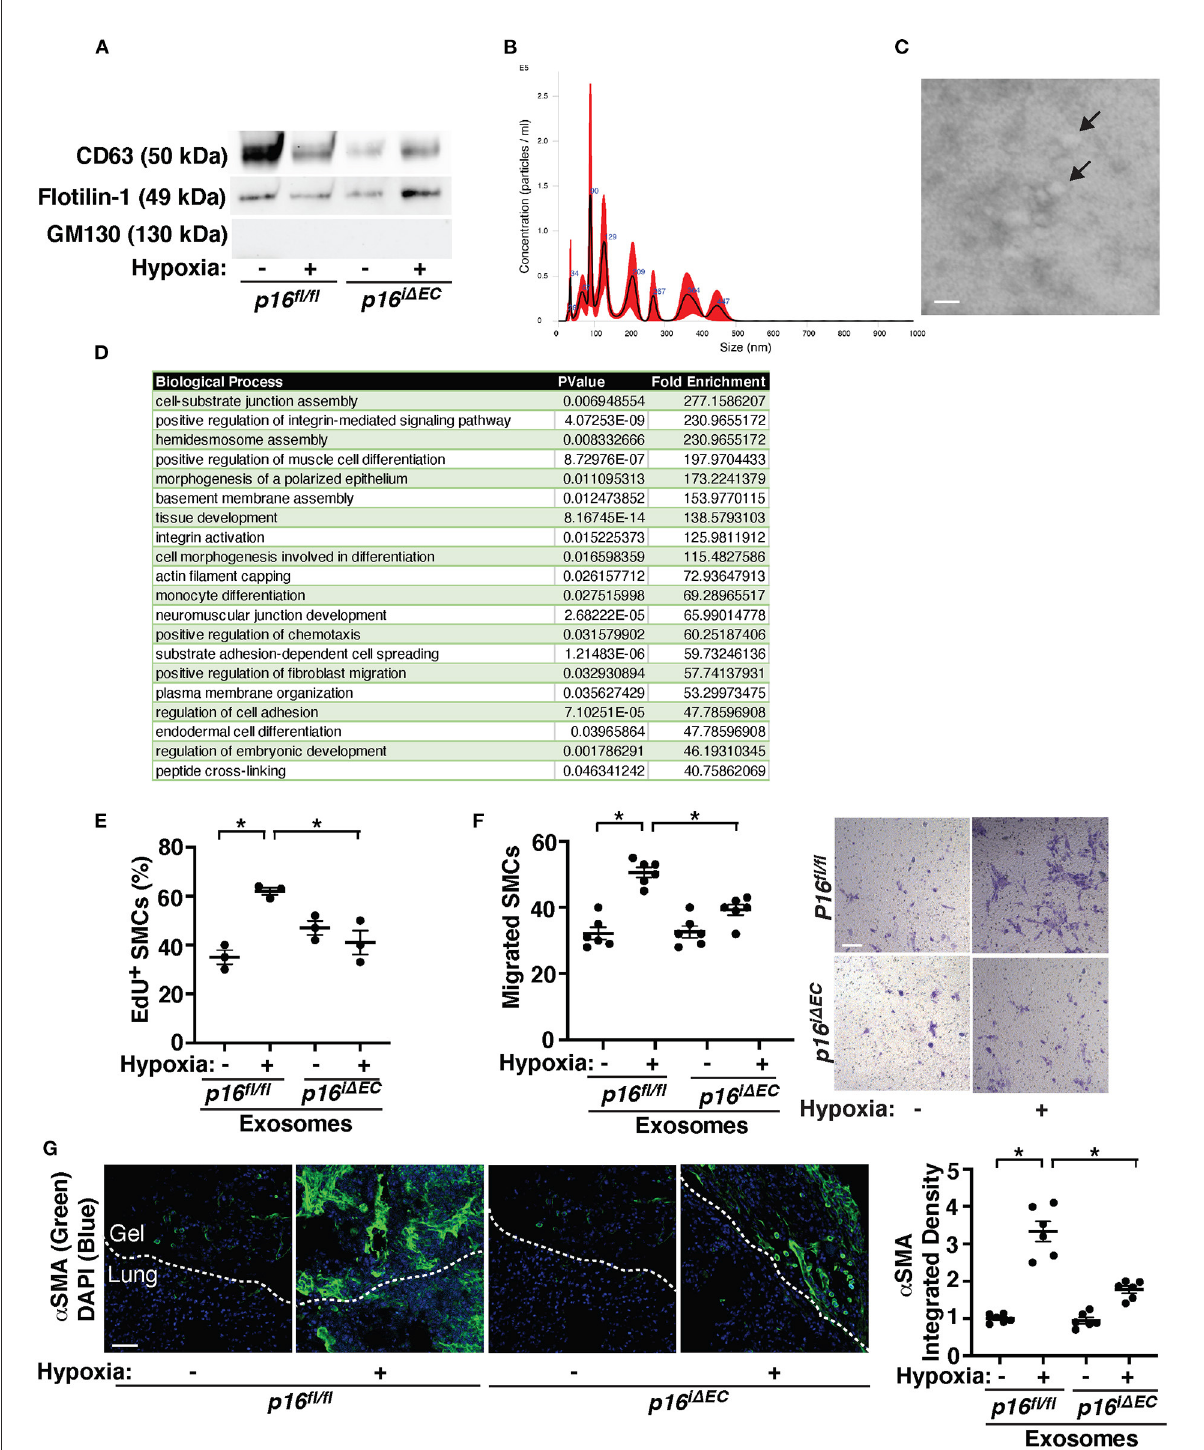
FIGURE5 Exosomes from hypoxia-treated mouse lung ECs stimulate recruitment of α SMA-positive cells in the fibrin gel implanted on the mouse lungs. (A) IB analysis of CD63, Flotillin-1, and GM130 in exosomes collected from conditioned media of ECs isolated from tamoxifen-induced p16 fl / fl or p16 i 1 EC mouse lungs treated with normoxia or hypoxia for 3 weeks. (B) Size distribution and particle concentration of isolated exosomes analyzed using NTA. (C) TEM image of exosome morphology. Scale bar: 150nm. Arrows indicate exosomes. (D) List of top 20 BP GO terms of proteins differentially enriched in exosomes isolated from conditioned media of mouse lung ECs isolated from C57BL6 mouse lungs treated